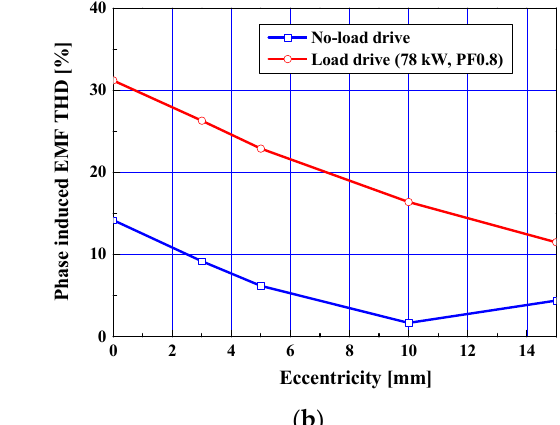
Figure 6. Wave form of the induced EMF according to the eccentricity: ( a ) no-load drive, and ( b ) load drive. As the eccentricity increases in Figure 6, it was expected that this would reduce the fundamental component with the root mean (rms) value for the wave form of the induced EMF. The fundamental component with the rms value is denoted as the fundamental com- ponent below. Figure 7 shows the fundamental component and the THD of the induced EMF at the no-load and load drives according to the eccentricity. In Figure 7a, the fundamental components of the induced EMF at the no-load and load drives decreased. However, the change rates for the two fundamental components were 4.1% and 3.2%, respectively.